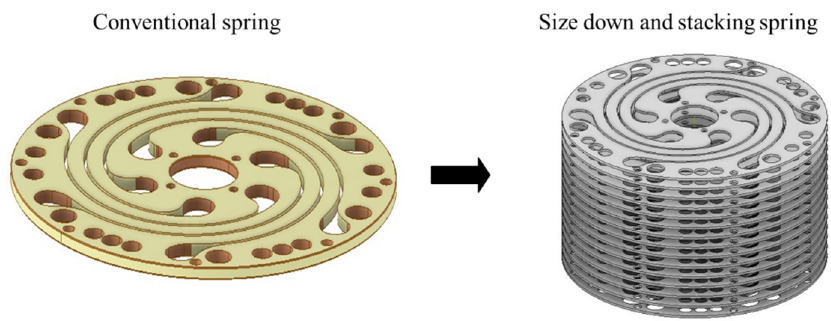
Figure 3. Design concept for the flat spiral spring stress reduction.